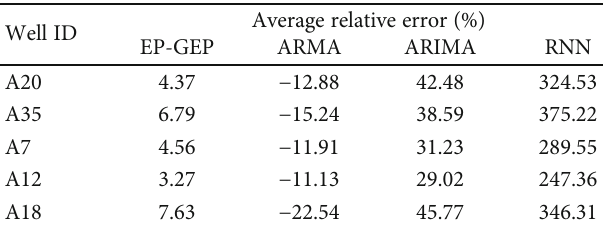
Table 2: Comparison of the average relative error of machine learning model predictions for di ff erent time series of oil wells. Well